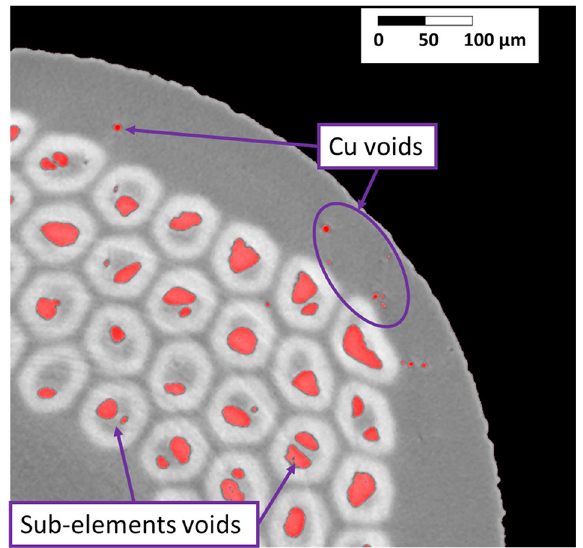
Figure 2. Detection of the voids in a x-ray tomography of the sample S20. Cu and sub-elements voids are in